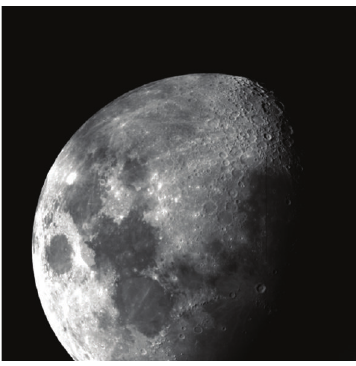
Figure 9: The WiFSIP CCD field of view on RoboTel (30 (cid:2) × 30 (cid:2)